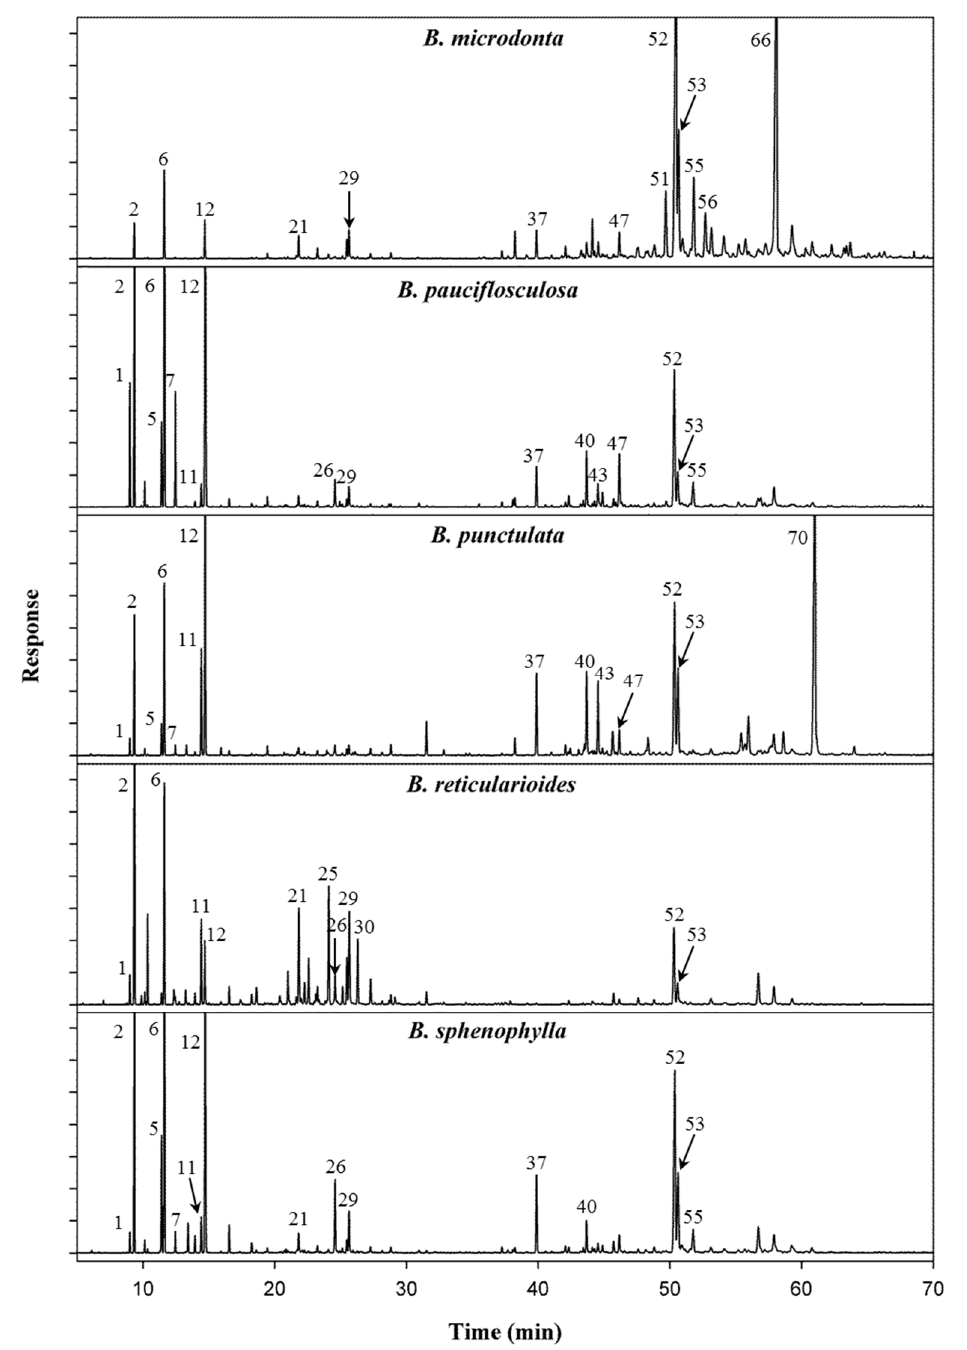
Figure 1. GC chromatograms of Baccharis species obtained for non-polar column. Compound identification is consistent with Table 1.